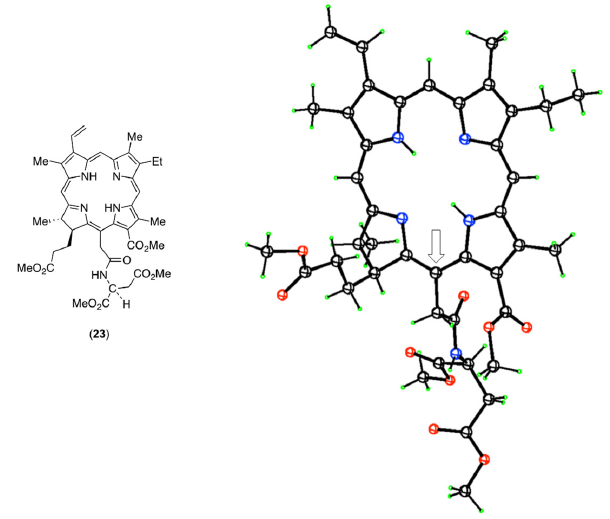
Figure 6. X-ray structure of authentic NPe6 tetramethyl ester ( 23